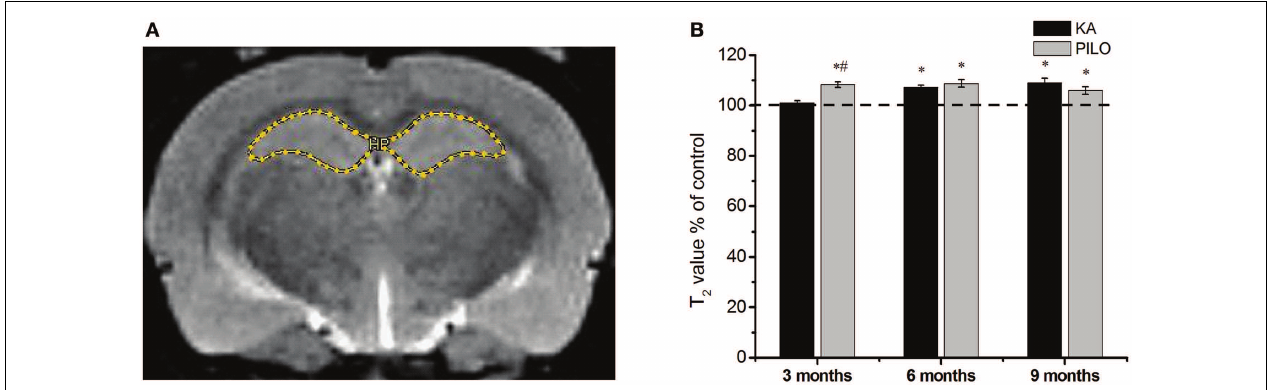
compared with KA-treated ( # P < 0.01) and control groups (* P < 0.05).This increase remained stable throughout the 9months period of observation.The KA group showsT 2 HP increases 6months after SE (* P < 0.05 compared with control), which remained stable thereafter. Data is expressed as a percentage of